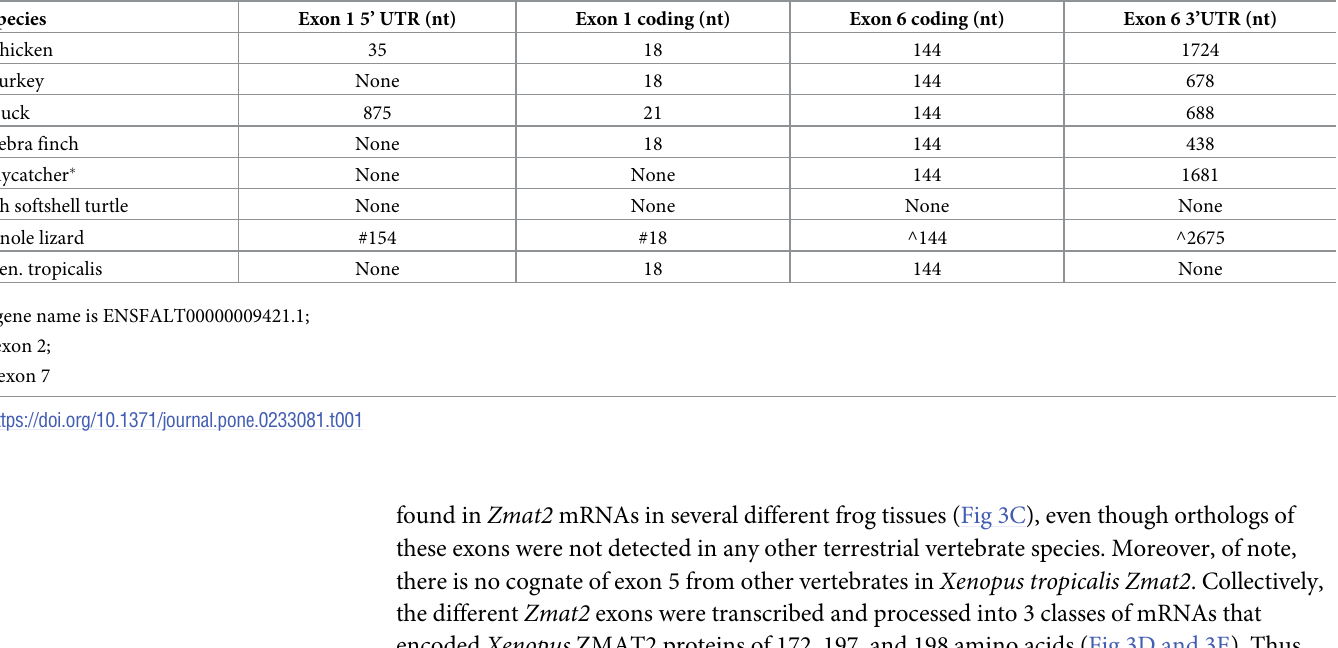
Table 1. Terrestrial vertebrate Zmat2 genes in Ensembl.